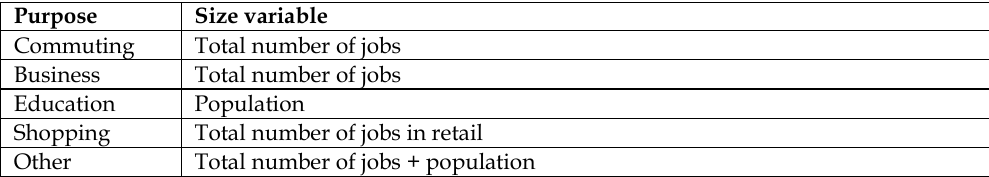
Table 5. Variables in the simplified destination choice